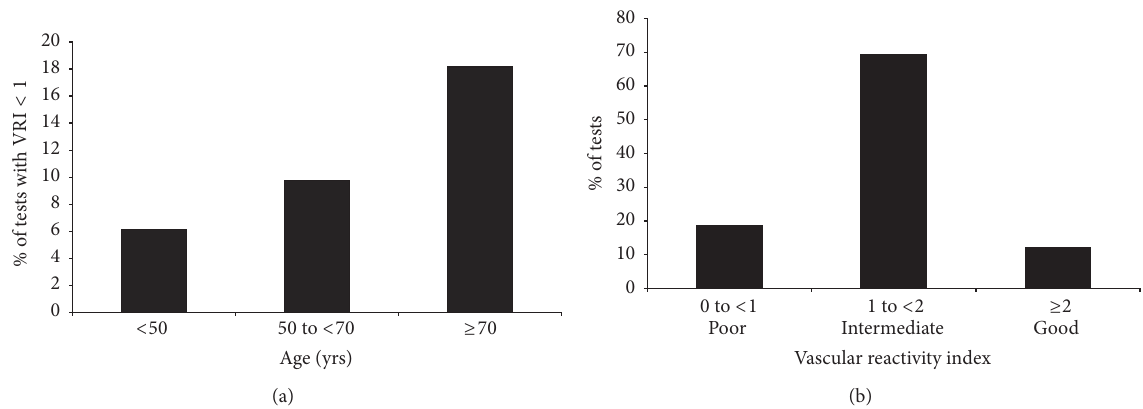
Figure 4: (a) Prevalence of poor VRI in different age groups. The frequency of having a poor VRI score (VRI < 1.0) is shown for the three age categories of age < 50 y, age 50–70 y, and age ≥ 70y. (b) Distribution of vascular reactivity index (VRI) in oldest age group. The percent of tests falling into categories of poor, intermediate, and good vascular reactivity is shown for patients age ≥ 70